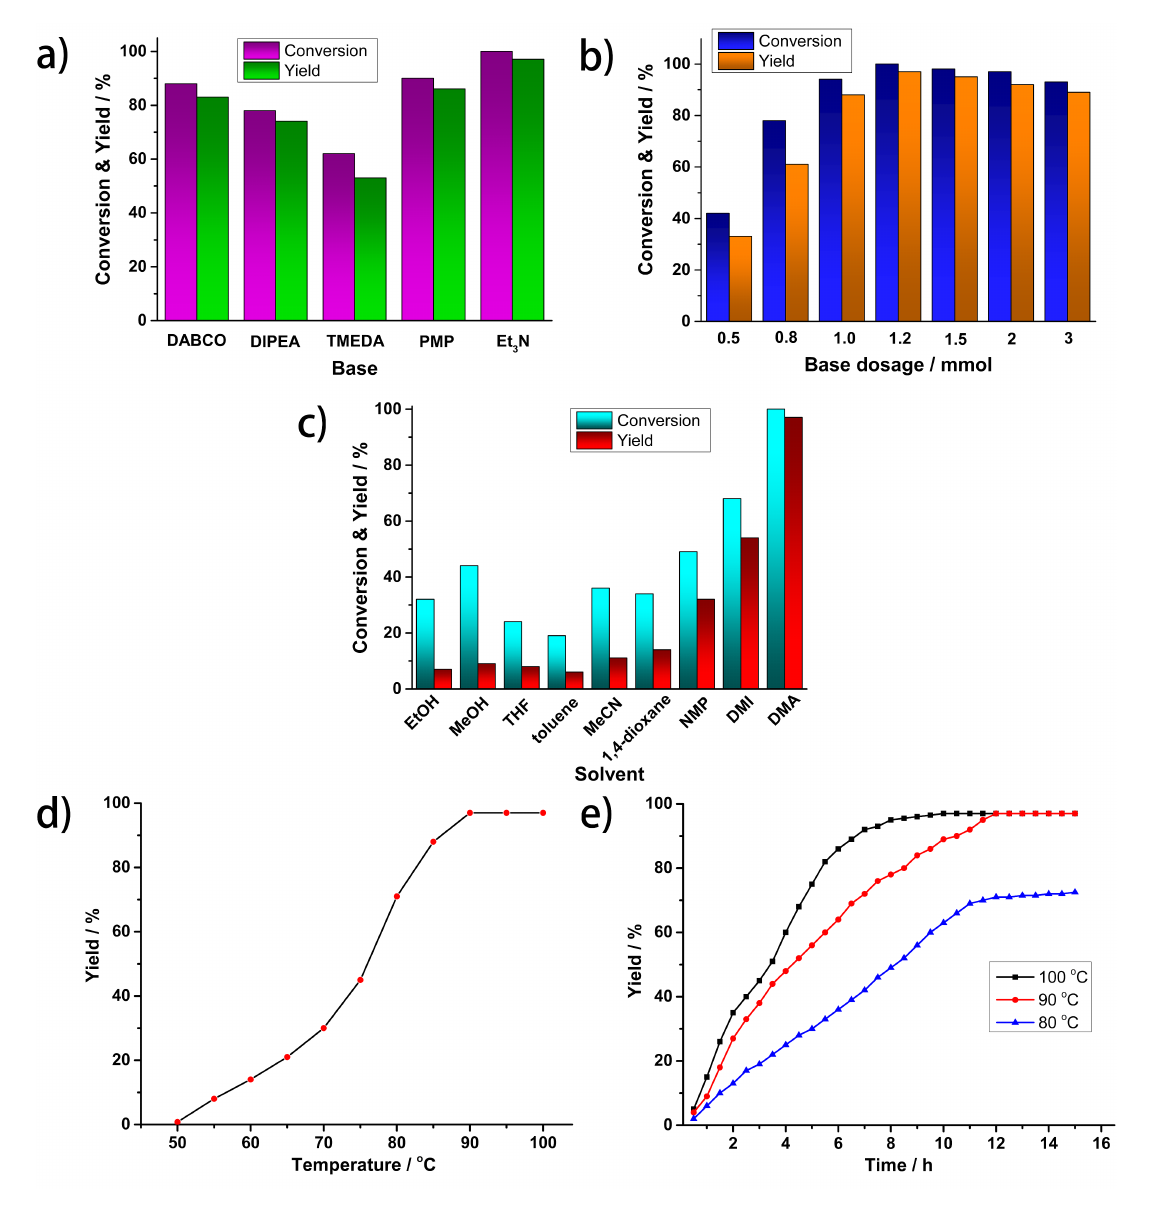
Figure 1: Rhodium-catalyzed reductive carbonylation of iodobenzene with CO and H 2 to afford benzaldehyde. a) Effects of the tested bases; b) effects of base amount; c) effects of tested solvents; d) temperature screen; e) yields at different times for reactions performed at 80, 90 and 100 °C (every point represents an average result of three parallel experiments). Conversions and yields were determined by GC using dodecane as an internal standard. Standard conditions: PhI (1 mmol), RhCl 3 ·3H 2 O (2.5 mol %), PPh 3 (10 mol %), base (1.2 mmol, if not stated otherwise), DMA (2 mL, if not stated otherwise), CO/H 2 (5 bar:5 bar), temperature 90 °C (if not stated otherwise), time 12 h (if not stated otherwise).